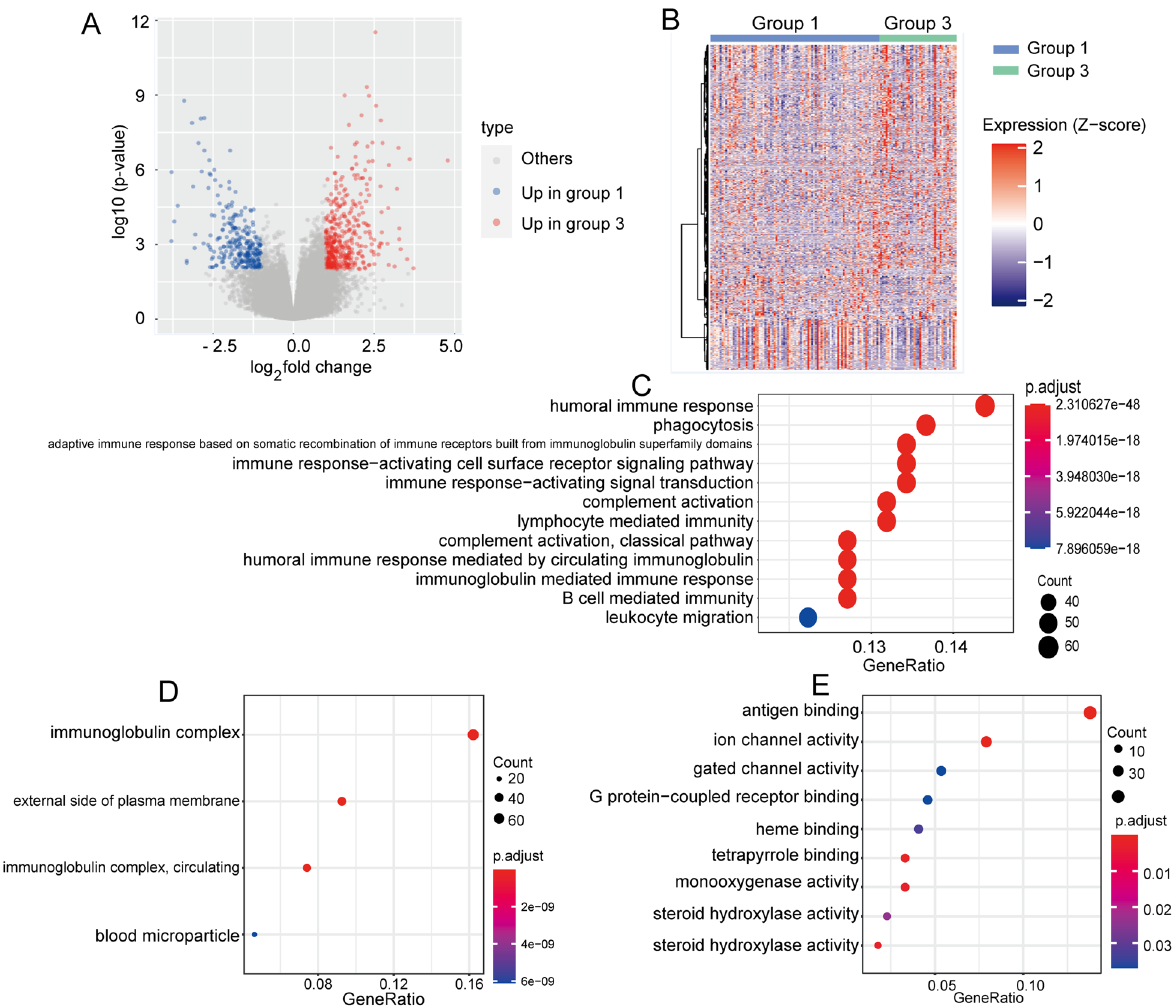
Figure 4. Functional enrichment analysis of groups 1 and 3. ( A ) Volcano map of DEGs between groups 1 and 3. ( B ) Heatmap of DEGs between groups 1 and 3. Most of the DEGs were upregulated in group 3. ( C ) Biological processes (BP) identified from gene ontology (GO) enrichment analyses of DEGs. ( D ) Cellular components (CC) identified from GO enrichment analyses of DEGs. ( E ) Molecular functions (MF) identified from GO enrichment analyses of DEGs. Most enrichments were in specific and non-specific immune response